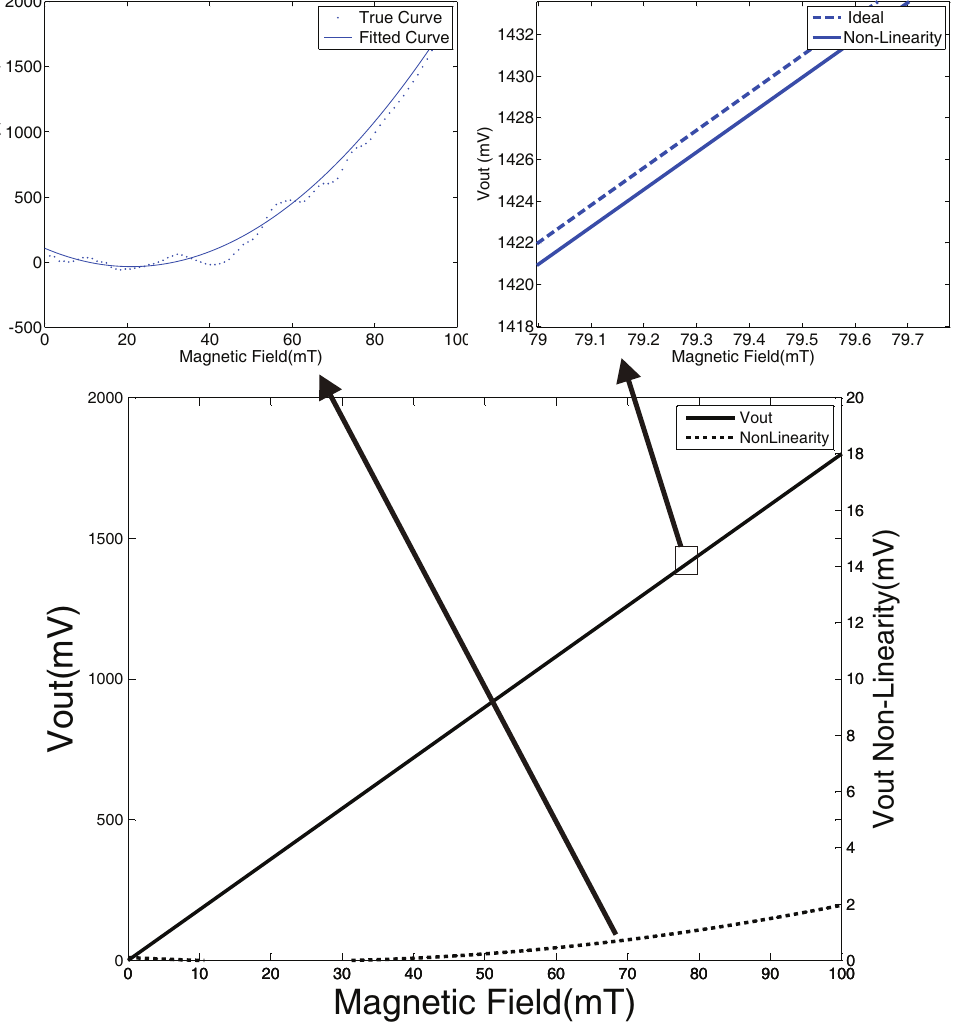
Figure 6. ( Upper left ) In the subgraph, the non-linearity relationship of the magnetic field intensity and voltage is represented. The fitting curve is obtained from the real curve through the polynomial fitting method; ( Upper right ) The subgraph shows the relationship of the magnetic field intensity and the output